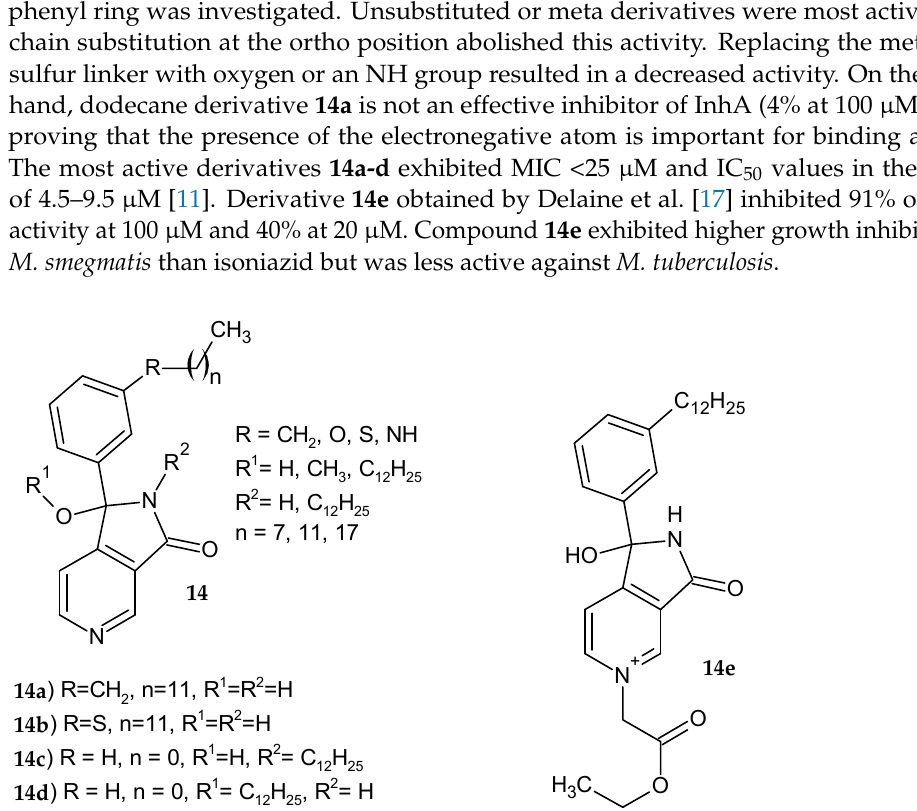
Figure 9. Imidazo[1’,2’:1,2]pyrrolo[3,4 ‐ c ]pyridin ‐ 5 ‐ one derivatives 13 with anti ‐ RSV activity and the candidate for preclinical studies 13a .